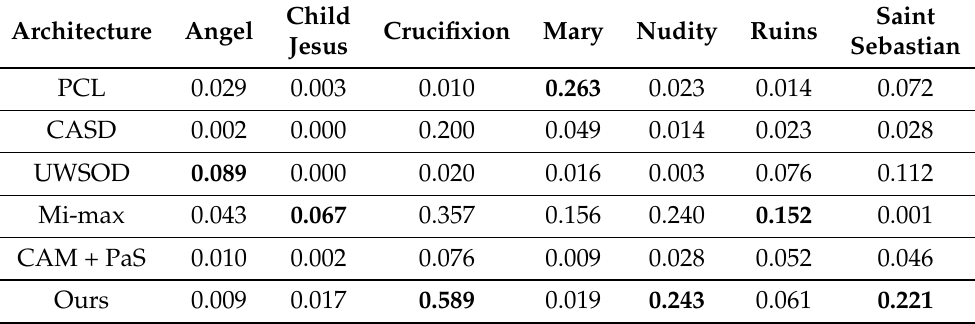
Table 9. Per-class WSOD performance on IconArt —Detection capabilities are evaluated on the IconArt test set for each class using the AP metric. The best-performing architecture for each class is highlighted in bold.